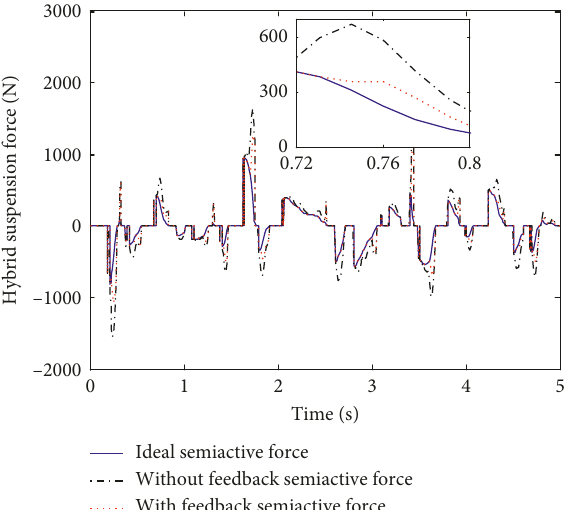
Figure 15: Semiactive force of the hybrid